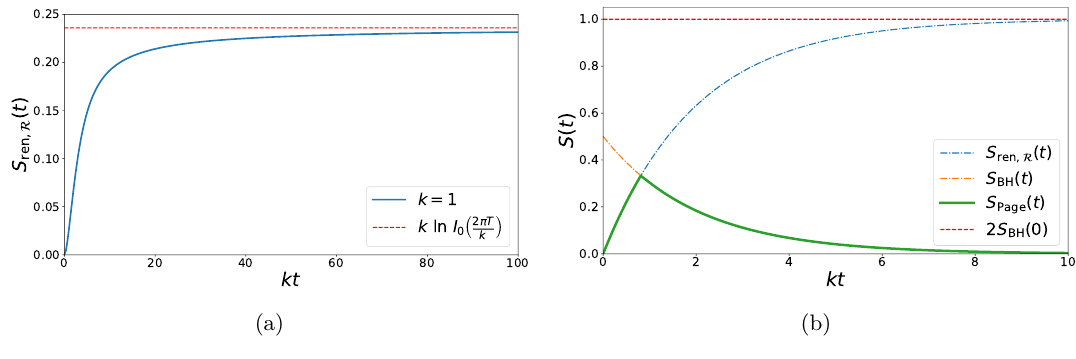
. It starts at 0 2 π ( t ) (3.26) and ren , R